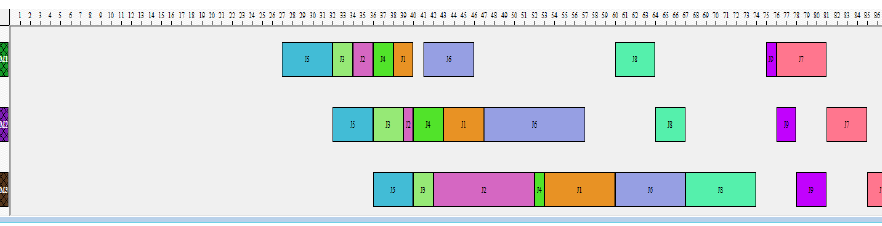
Figure 9. Gantt chart of the best solution with nine jobs by